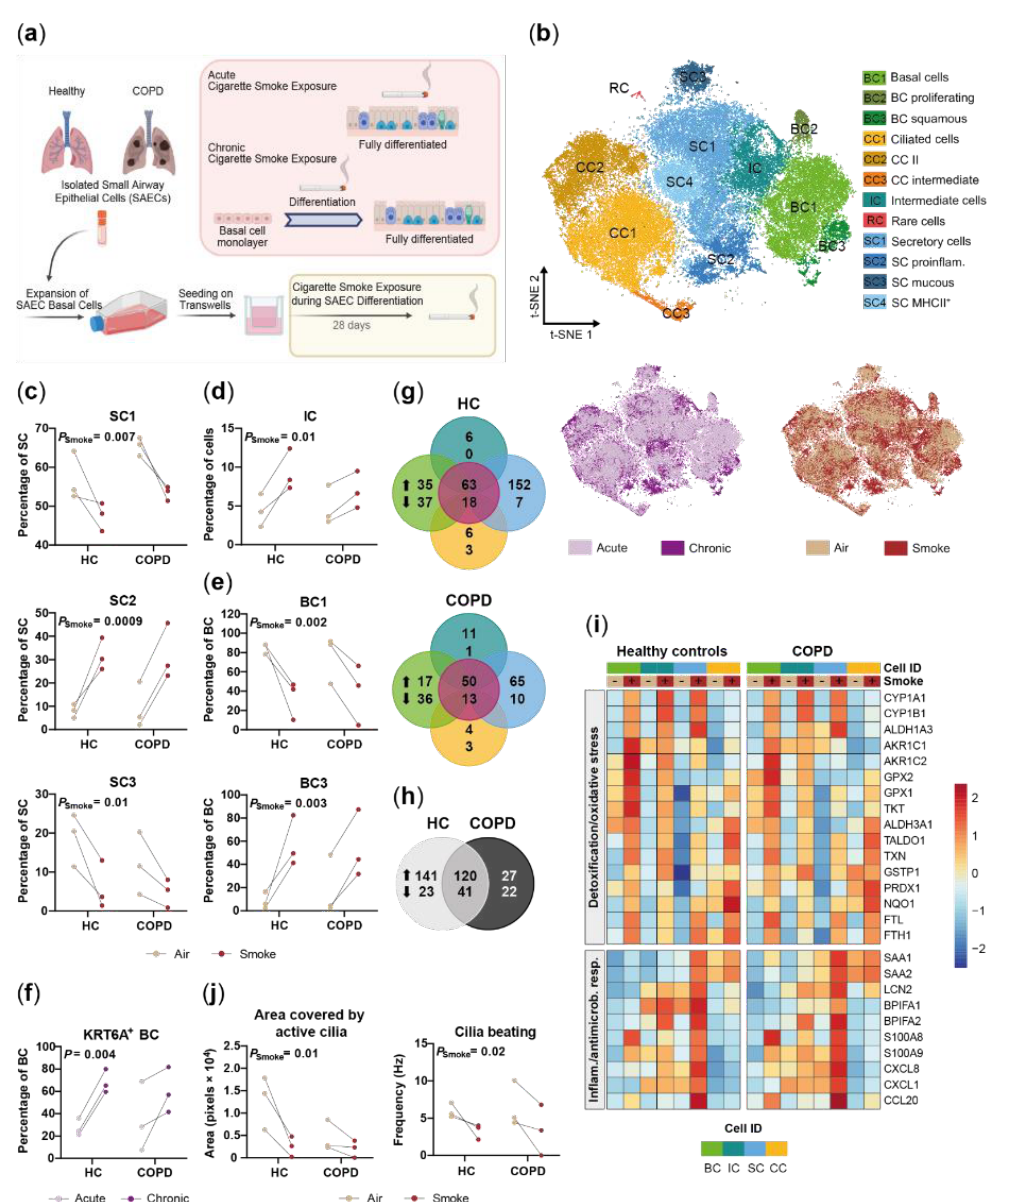
Figure 5. Impact of smoke exposure on differentiating small airway epithelial cells. ( a ) Experimental design to investigate the impact of chronic cigarette smoke exposure throughout differentiation contrasted with the design applied to examine the effect of acute smoke exposure. ( b ) T-SNE plots represent the integrated scRNA-seq data sets of both experiments and depict annotated cell (sub)populations (upper panel) as well as the experimental origin (lower panel, left) and smoking status (lower panel, right) of the cells. ( c – e ) Smoke-induced shifts of selected SC and BC subpopulation frequencies and the total IC frequency after chronic smoke exposure throughout differentiation. Data of the respective HC and COPD donors are connected. ( f ) KRT6A + BC frequency in SAEC ALI cultures chronically exposed to smoke during differentiation compared to acute smoke exposure. ( g ) Summary of the significantly up- and down-regulated genes (adj. p < 0.05, abs. fold change ≥ 1.5) after chronic smoke exposure across the main SAEC populations (BC, IC, SC and CC according to the color code in ( i )) of HC and COPD donors ( n = 3, each). Core genes de-regulated in at least two cell types are summarized in the center (violet circle). ( h ) Comparison of the total gene sets significantly de-regulated by chronic smoke exposure in at least one of the four main cell populations of HC and COPD donors. ( i ) Relative expression of selected genes from the core gene set that are associated with cellular detoxification/oxidative stress and inflammatory/antimicrobial response across the four main SAEC populations. Average gene expression is shown for air control and smoke-exposed (chronic) cells from both, HC and COPD donors. ( j ) Impact of chronic smoke exposure on cilia function as determined by the area covered by active cilia and frequency of cilia